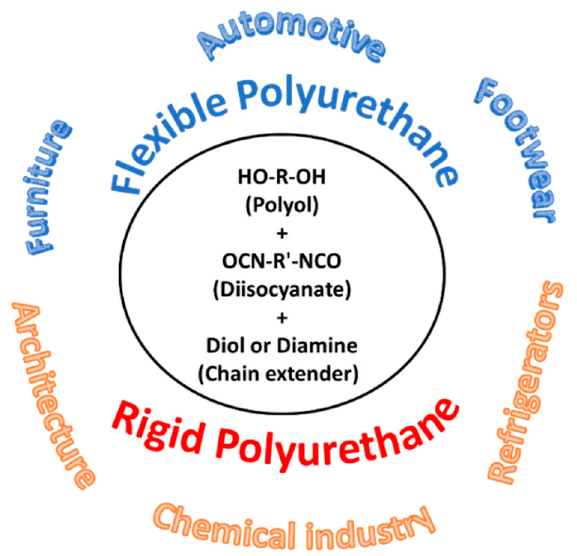
Figure 9. Applications of polyurethane foams (Adapted from [89] ).